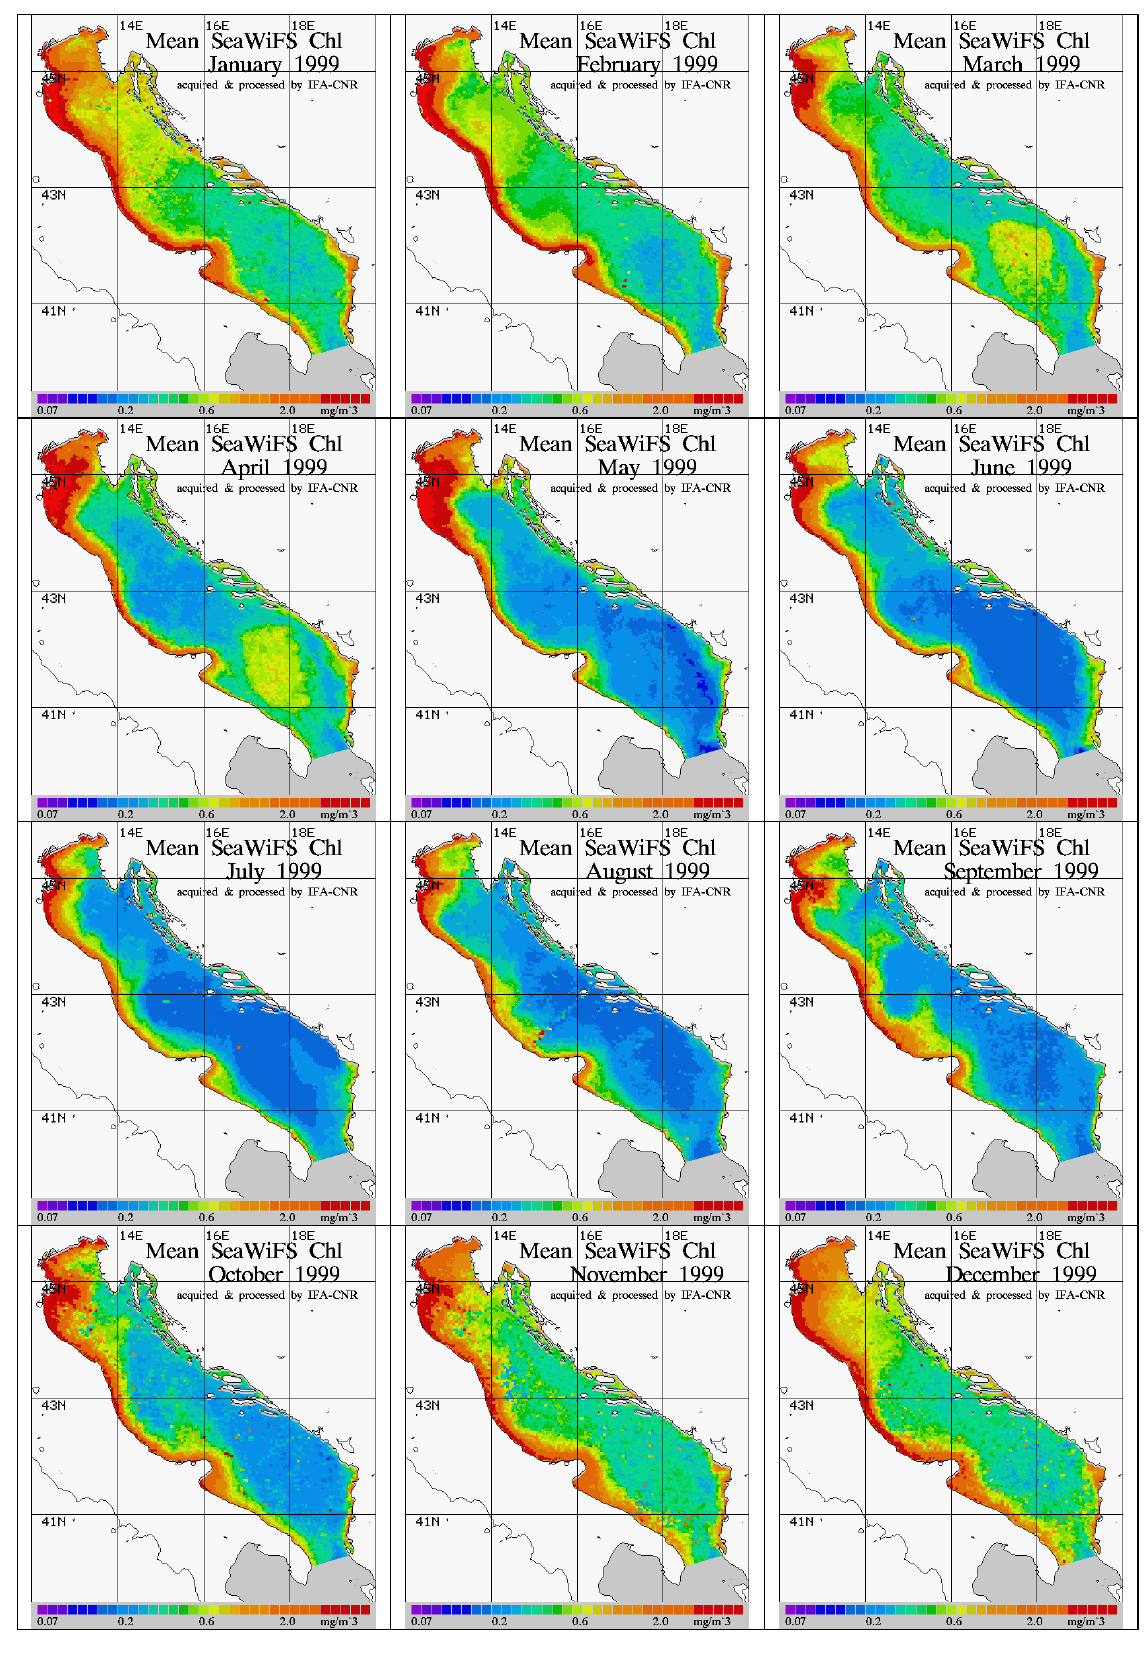
Fig. 3a. Monthly averaged Chl fields for the January – December 1999